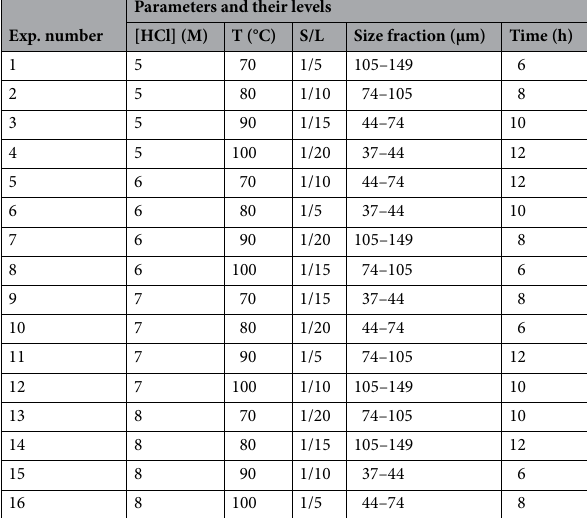
Table 4. The experimental plan designed by orthogonal L16: 4 5 of the Taguchi method.